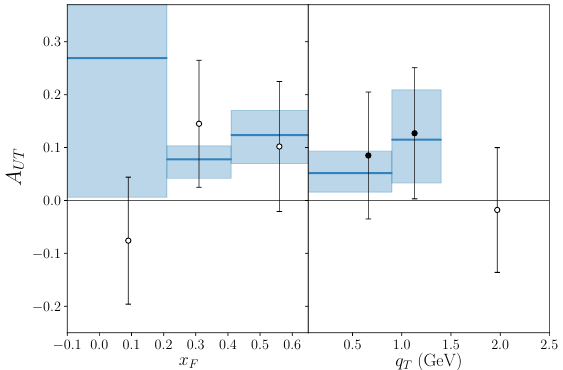
Figure 11. Description of Compass DY data [40] as a function of x F and q T (GeV). Solid (open) symbols data used (not used) in the fit. Blue line is the CF and the blue box is 68%CI of the fit of the data and prediction for the data not used in the